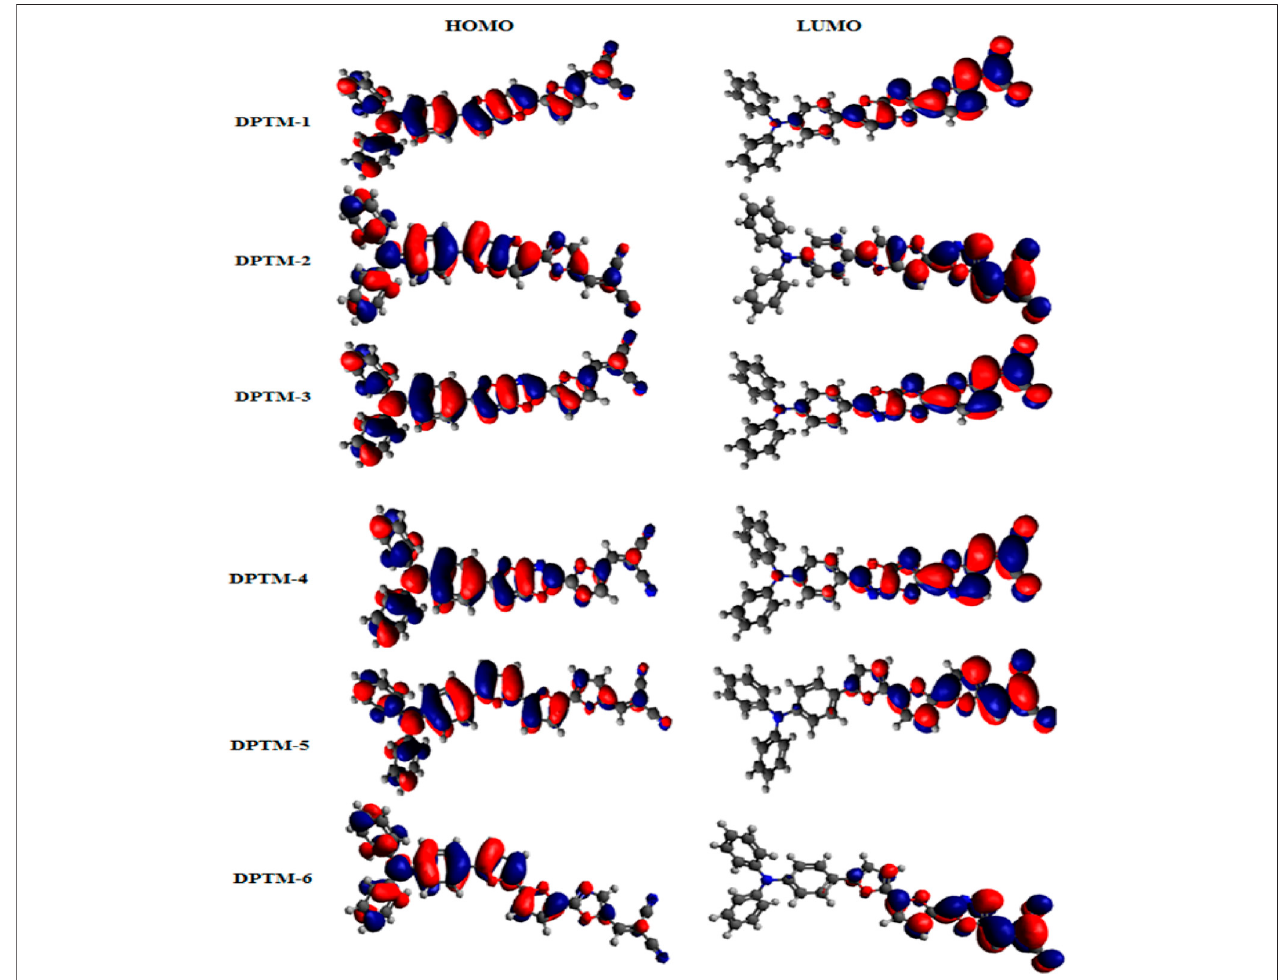
FIGURE 3 | HOMOs and LUMOs of the studied dyes (DPTM-1 to DPTM-12).